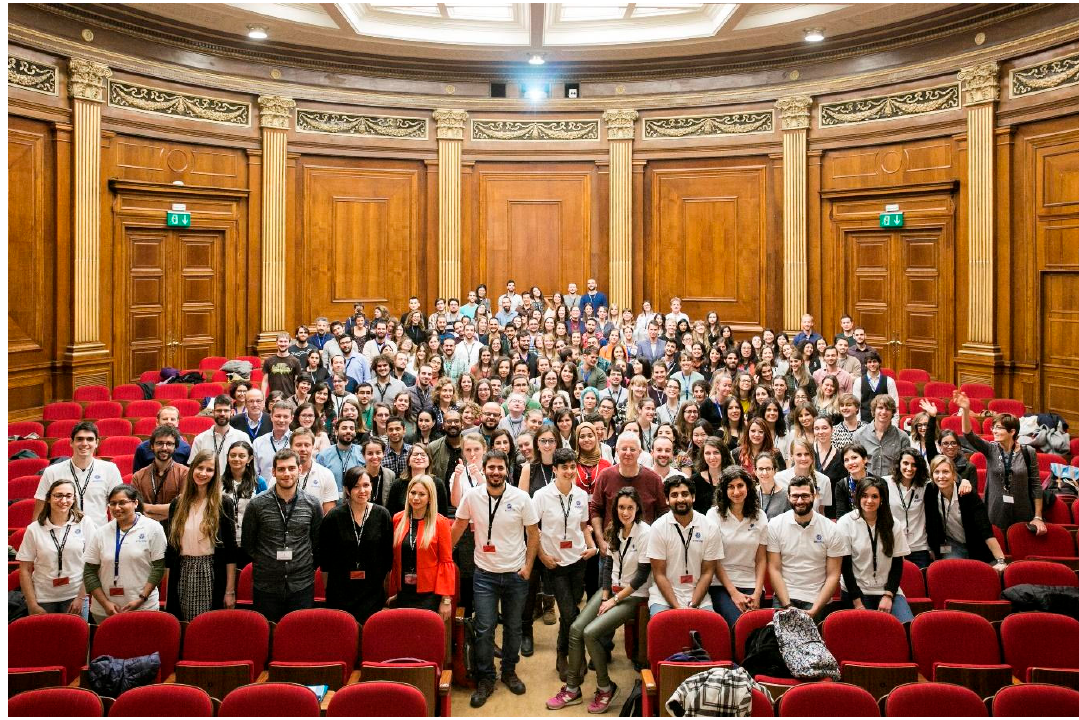
Figure 1. Attendees at ENABLE 2017.